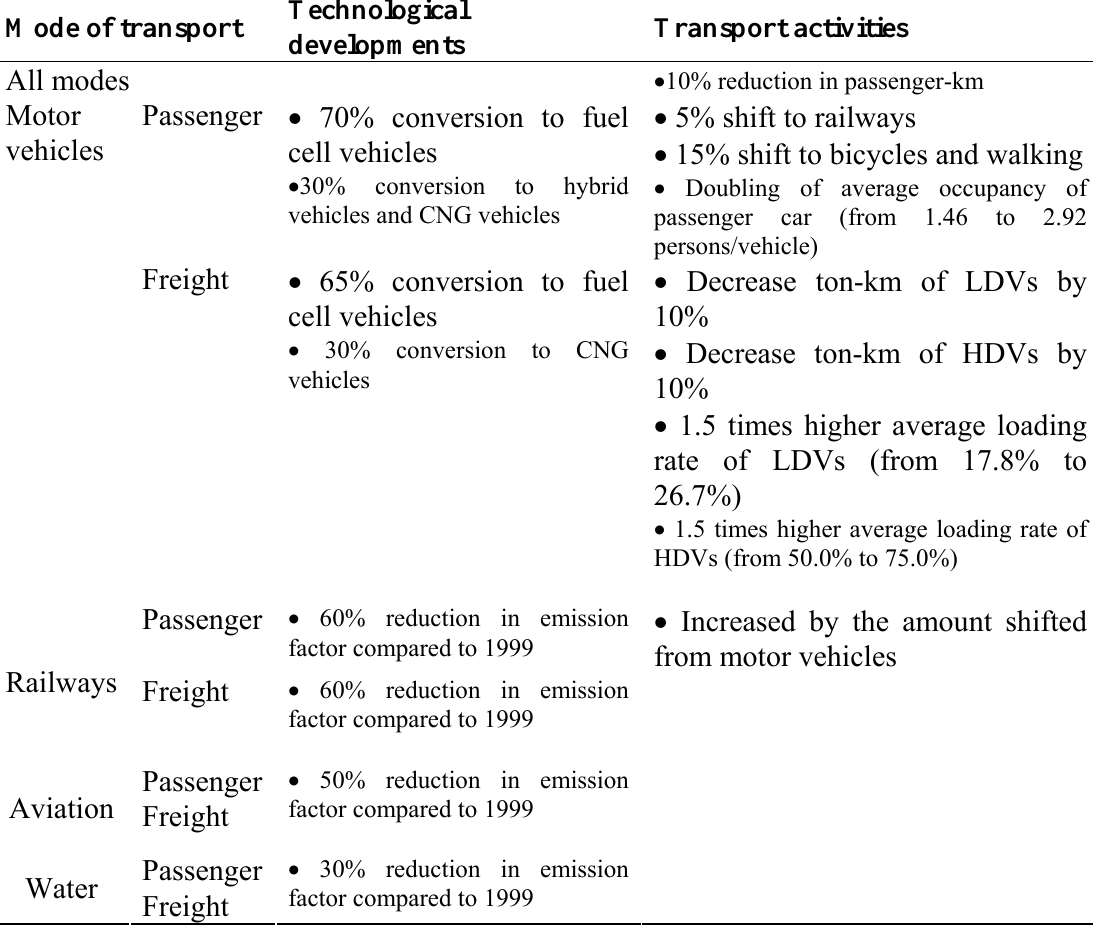
Table 10. Assumptions on technological developments and transport activities in EST3 Scenario (for Japan as a